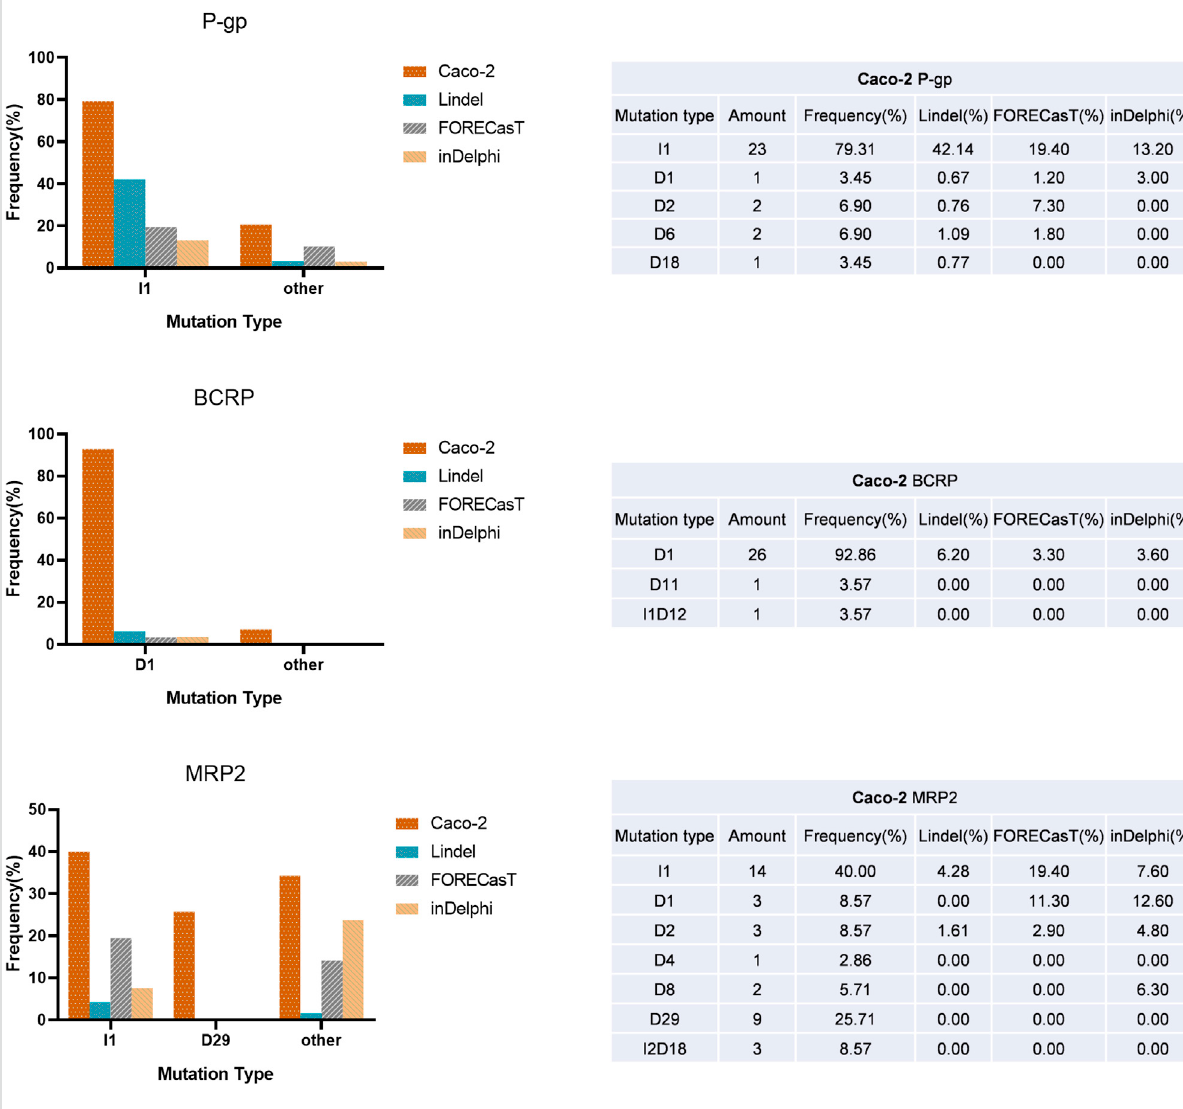
FIGURE 3 A summary of indel outcomes of KO clones and comparing the indel frequency with the three prediction models. Left: the frequency of indels. Right: the summary of mutation type for P-gp, BCRP and MRP2 targets. The abbreviation of mutation type: I, insertion; D, deletion; the number means the nucleotides number indel or insertion (e.g., D1 means 1 nucleotide deleted in target